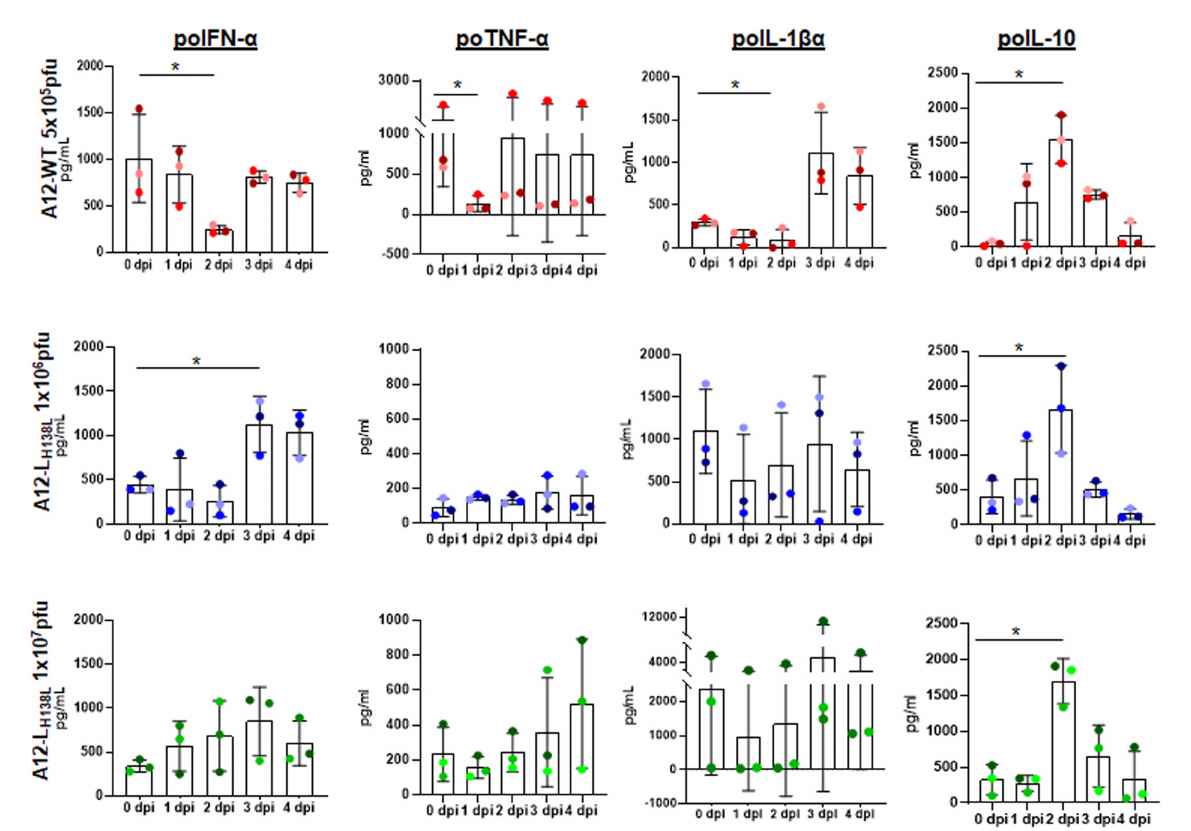
FIGURE6 Cytokine profile in animals inoculated with FMDV A12-WT or A12-L H138L . Serum levels of porcine IFN- α , IL-10, IL-1 β , and TNF- α were detected by ELISA at different times post virus inoculation. Results are expressed in pg/ml. Error bars represent the variation within the three animals from each group. Each color grade dot represents the same animal throughout the graphs ( P <